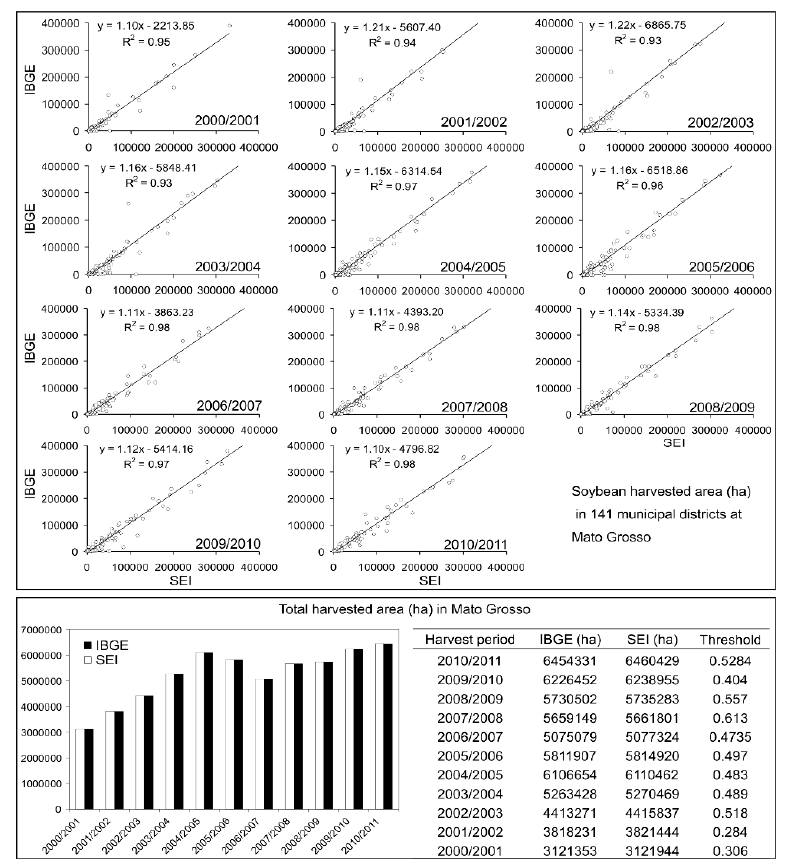
Figure 5. Evaluation of the model for soybean harvested area estimation based on Moderate Resolution Imaging Spectroradiometer (MODIS) data, when compared to IBGE statistics per municipality and